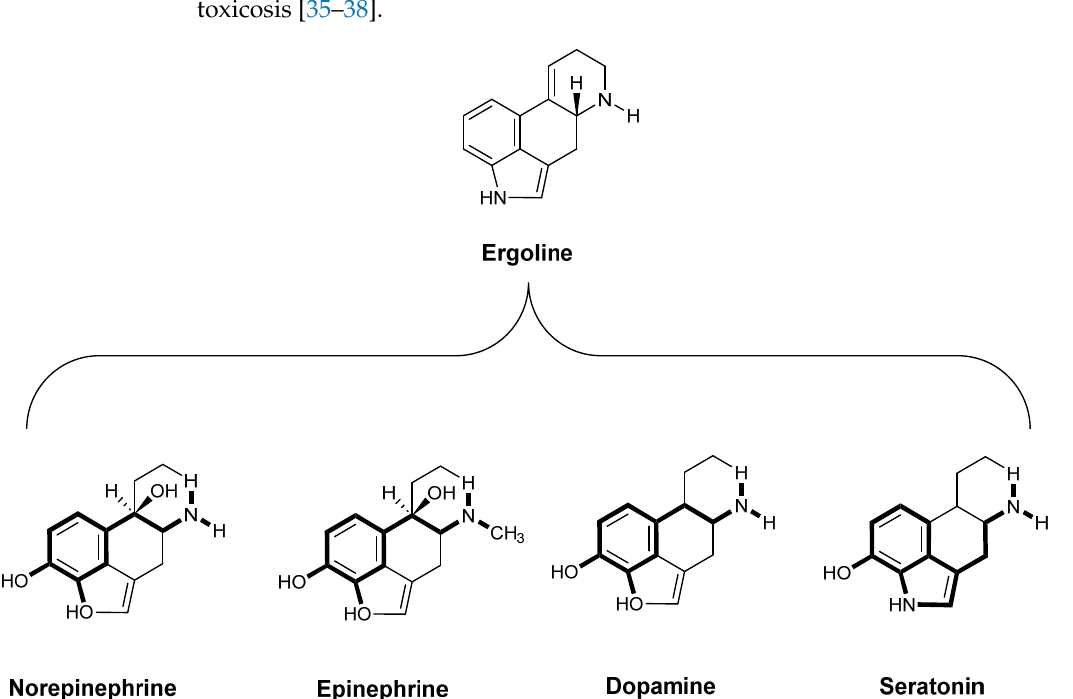
Figure 2. The tetracyclic ergoline ring system overlaid with catecholamines and serotonin (bold) to demonstrate the similarities between these structures. The ergoline ring system serves as a suitable pharmacophore for these neurotransmitters (modified from Britt [39]).